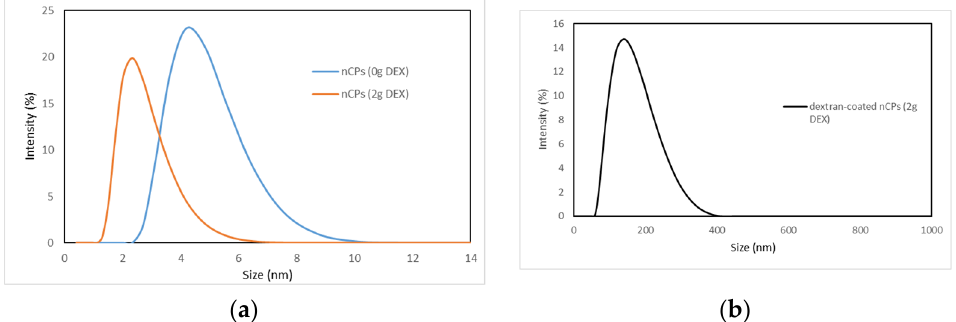
Figure 6. Particle size distributions of ( a ) nCPs (0g DEX) and nCPs (2g DEX) and ( b ) dextran-coated nCPs (2g DEX).